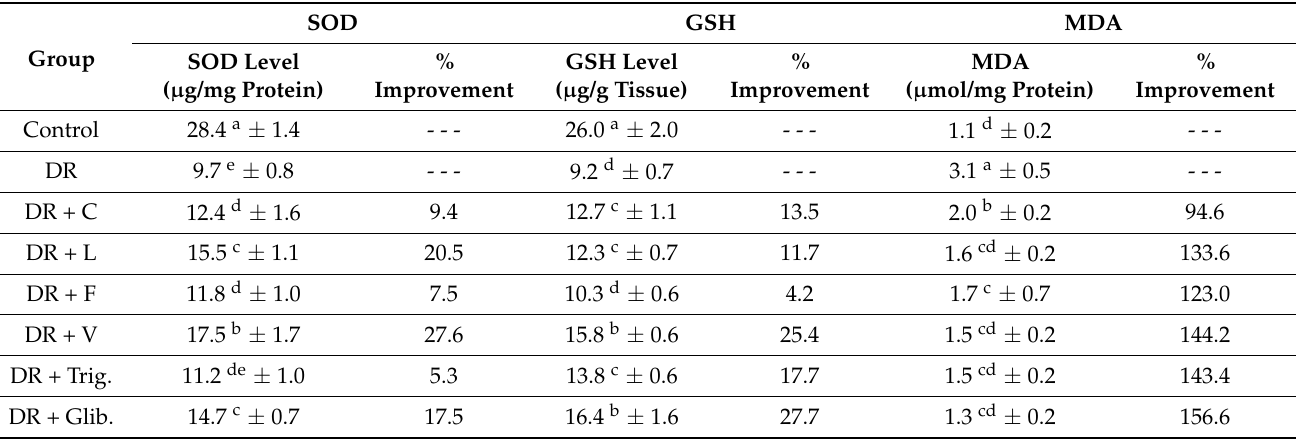
Table 2. Effect of different treatments on liver superoxide dismutase (SOD) activity, liver glutathione (GSH) level, and liver malondialdehyde (MDA) of diabetic rats (n =